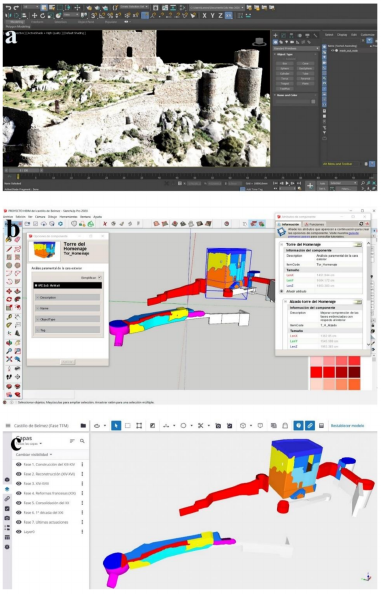
Figure 16. ( a ) Example of a photogrammetric acquisition. ( b ) SketchUp software modeling. ( c ) TrimbleConnect BIM platform. Copyright “Ager Mellariensis” / AEI FEDER HAR